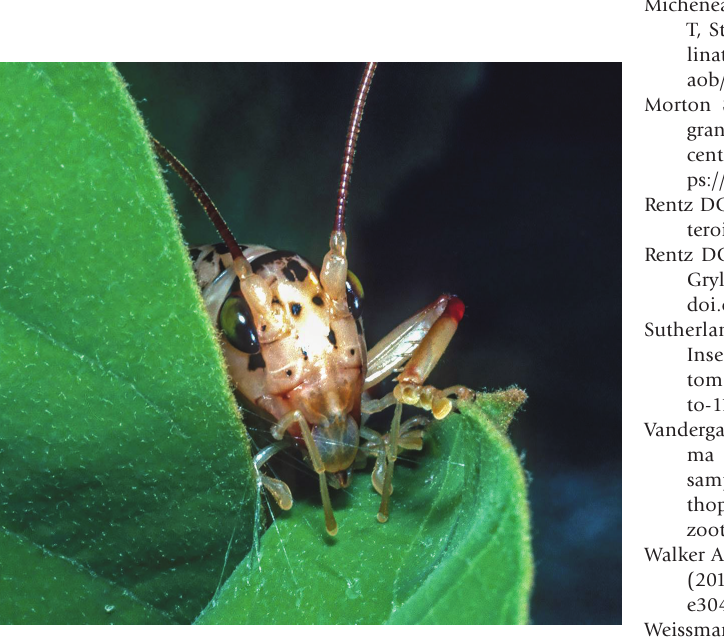
Fig. 8. The same individual as in Fig. 5; spinning silk strands to secure leaves for shelter